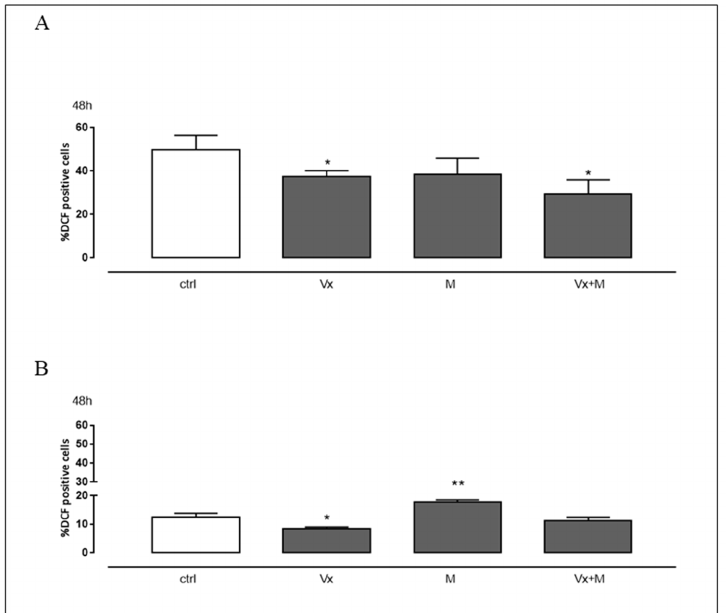
Figure 3. Vx-809 and Matrine co-treatment reduces FC-induced oxidative stress. Vx-809 and Matrine co-treatment interferes in the molecular trafficking. Reactive oxygen species (ROS) formation was evaluated by means of 2 ′ ,7 ′ dichlorofluorescein diacetate (H 2 DCF-DA) probe in A549 ∆ ( A ) and in A549wt ( B ). Vx-809 (2 µM) and Matrine (300 µM) were administered for 48h. ROS production was expressed as mean ± SEM of percentage of DCF positive cells of at least three independent experiments each performed in duplicate. Data were analyzed by Mann–Whitney U test. * p < 0.05 and ** p < 0.005 vs. untreated cells.